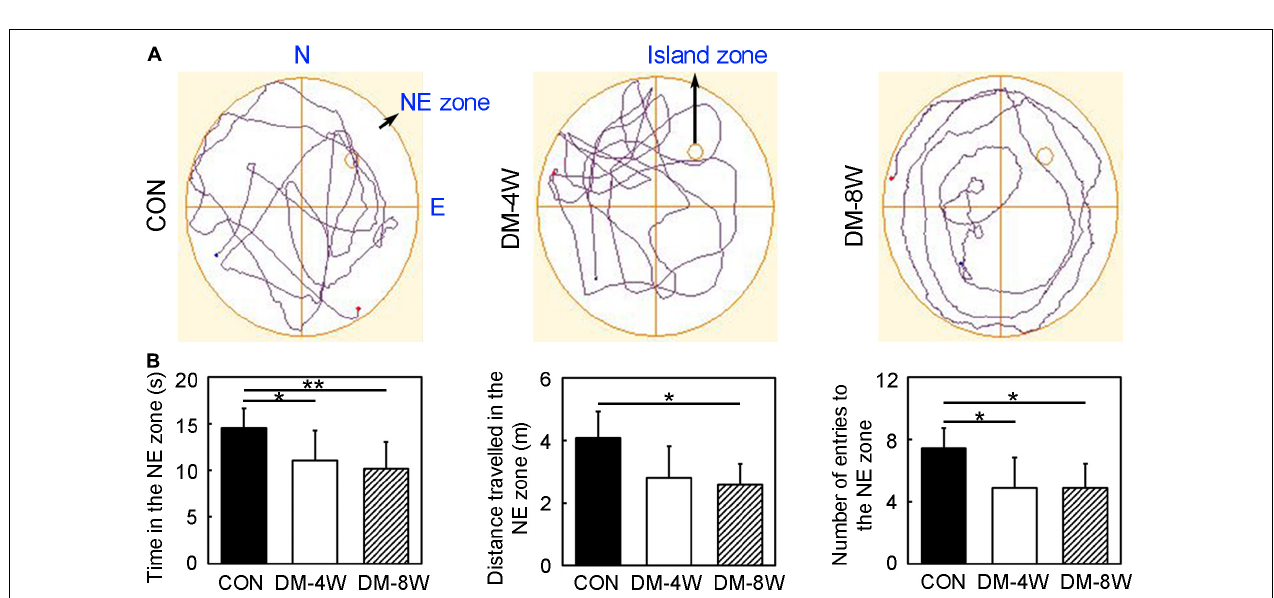
FIGURE 1 | Experimental design and establishment of a hyperglycemic mouse model. (A) Diagram of experimental design. (B) Establishment of hyperglycemic mouse model. Line chart shows the blood glucose level after STZ injection. Data are mean ± SD, n = 12 per group, *** p < 0.001.